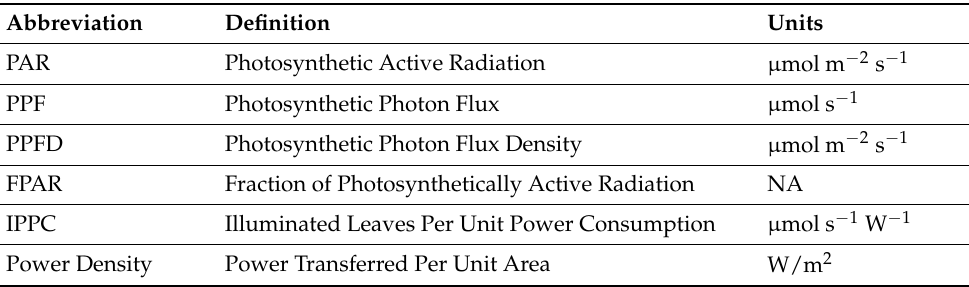
Table 1. Technical terms and abbreviations are used in the